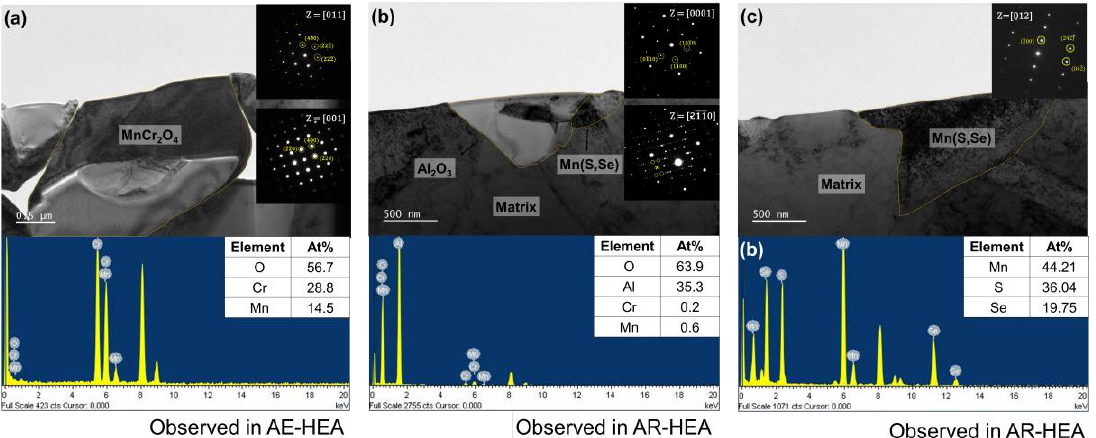
Figure 1. Crystallographic features of ( a ) MnCr 2 O 4 , ( b ) Al 2 O 3 , and ( c ) Mn(S,Se).